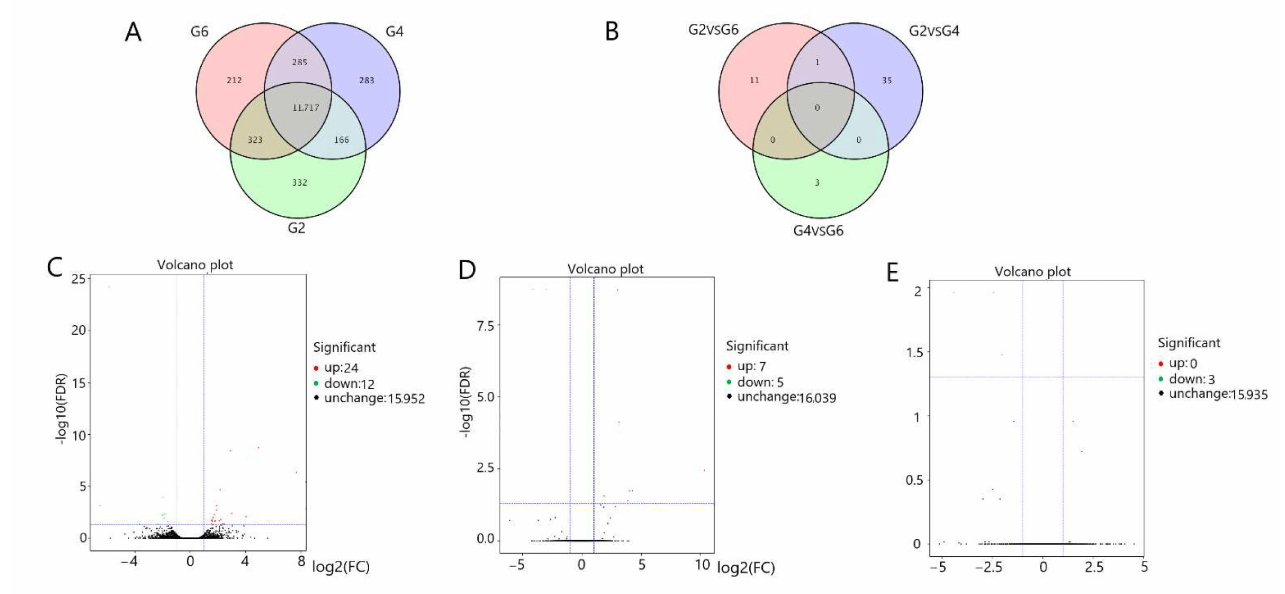
Figure 2. Gene expression patterns in the hypothalamus; ( A ) Gene set at different developmental stages in hypothalamus tissue; ( B ) DEGs expressed in the hypothalamus. DEGs expressed in a volcano plot in: ( C ) G4 vs. G2; ( D ) G6 vs. G2; ( E ) G6 vs. G4. G2, G4, G6 = 6-month-old, 18-month-old, 30-month-old Angus cattle hypothalamus,